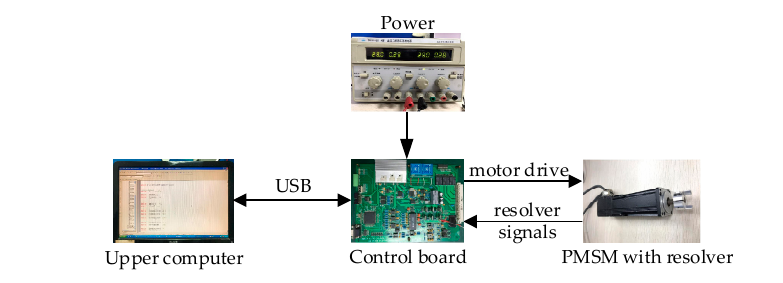
Figure 11. Experimental platform. Table 4. PMSM and resolver parameters.